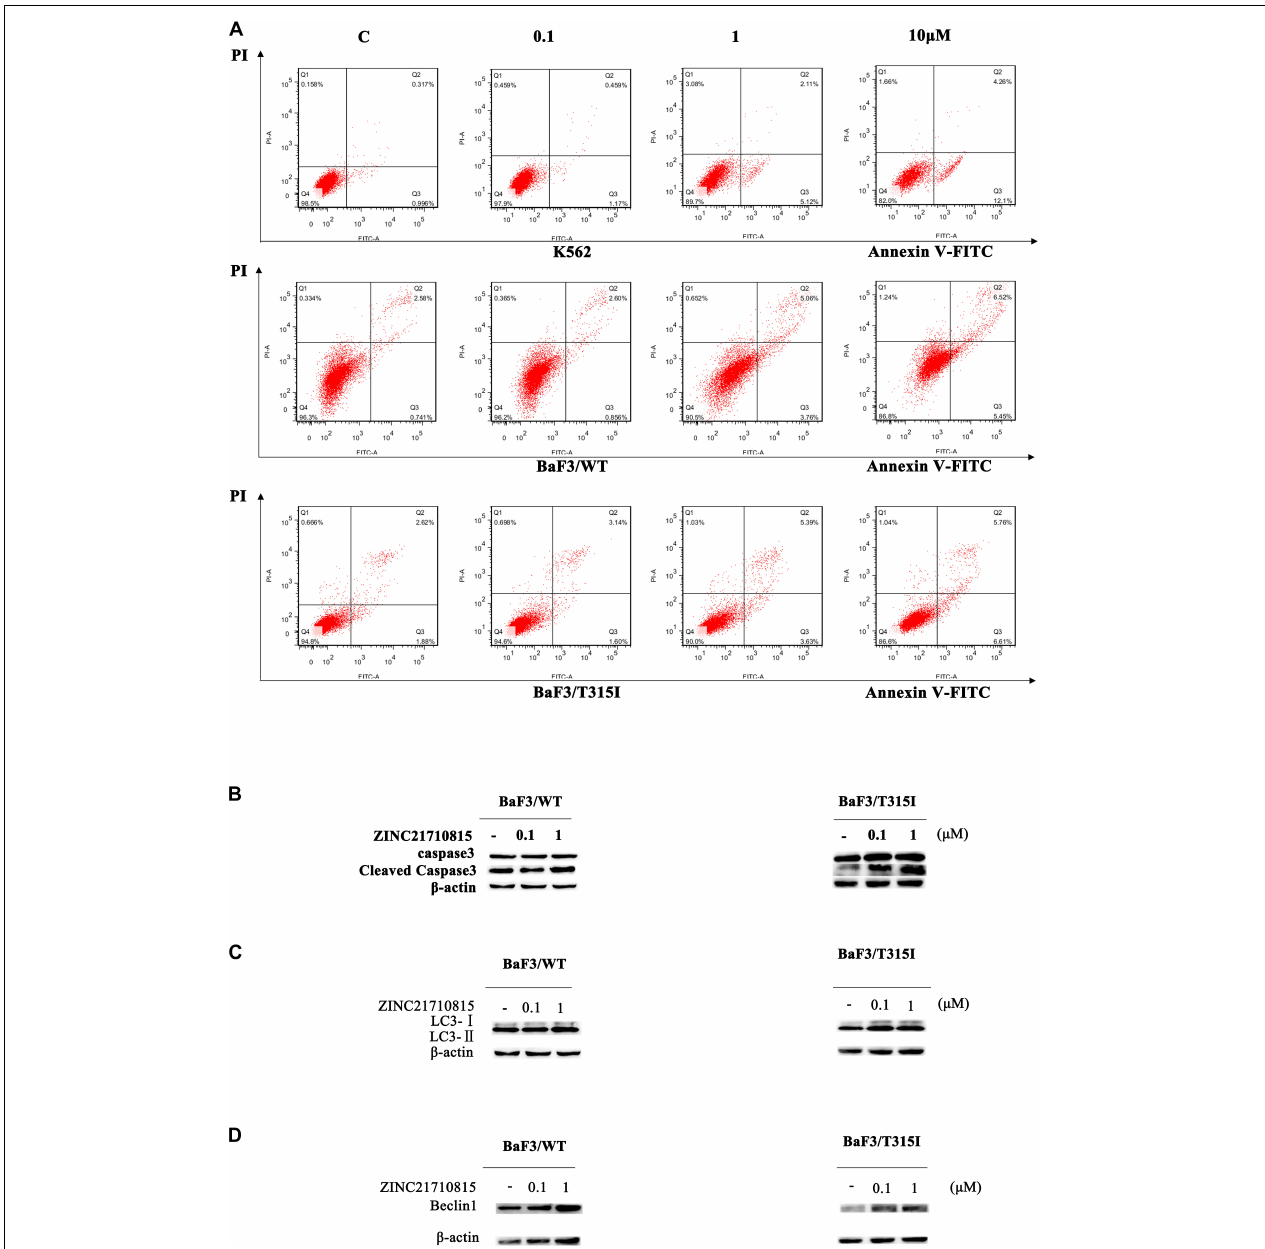
FIGURE 10 | ZINC21710815 induces apoptosis and autophagy in CML cells. (A) K562, BaF3/WT, and BaF3/T315I cells were incubated with various concentration of ZINC21710815 for 24 h at a density of 5 × 10 5 cells/well, stained using Annexin V-FITC and PT and analyzed by FlowJo. (B) Caspase-3 protein expression in BaF3/WT and BaF3/T315I cells incubated with 0 (vehicle), 0.1, or 1 µ M of ZINC21710815 for 48 h. LC3 (C) and Beclin1 (D) protein expression in BaF3/WT and BaF3/T315I cells incubated with 0 (vehicle), 0.1, or 1 µ M of ZINC21710815 for 48